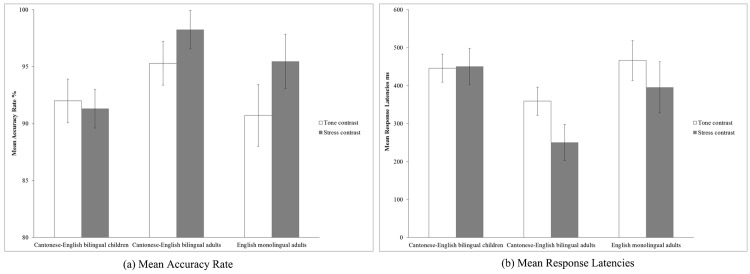
(a) Means showing proportion of correct responses (i.e. accuracy rates) for the three groups of participants toward Cantonese tone contrasts and English stress contrasts. Error bar represents 95% confidence intervals. (b) Means showing mean response latencies (i.e., reaction times) for the three groups of participants toward Cantonese tone contrasts and English stress contrasts. Error bar represents 95% confidence intervals.